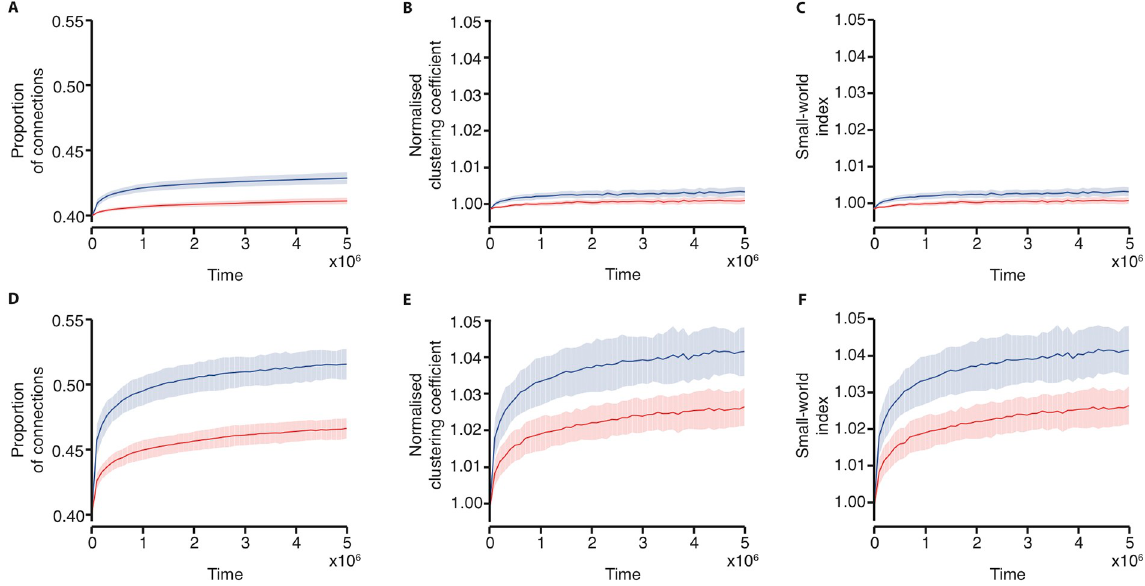
Fig 4. Changes in connectivity are related to the levels of potentiation and depression. (A) The proportion of connections in the network, (B) normalised clustering coefficient, and (C) small-world index across the course of 20 simulations with A D = A P = 0.5. (D) The proportion of connections in the network, (E) normalised clustering coefficient, and (F) small-world index across the course of 20 simulations with A and A P = 0.55. The networks are driven with burst dynamics which exhibit LRTCs ( H � 0.7, blue), compared with the same input randomly shuffled in time (red). Solid lines indicate the mean across the 20 simulations and the shaded area indicates the standard deviation. Results are shown on the same scale for